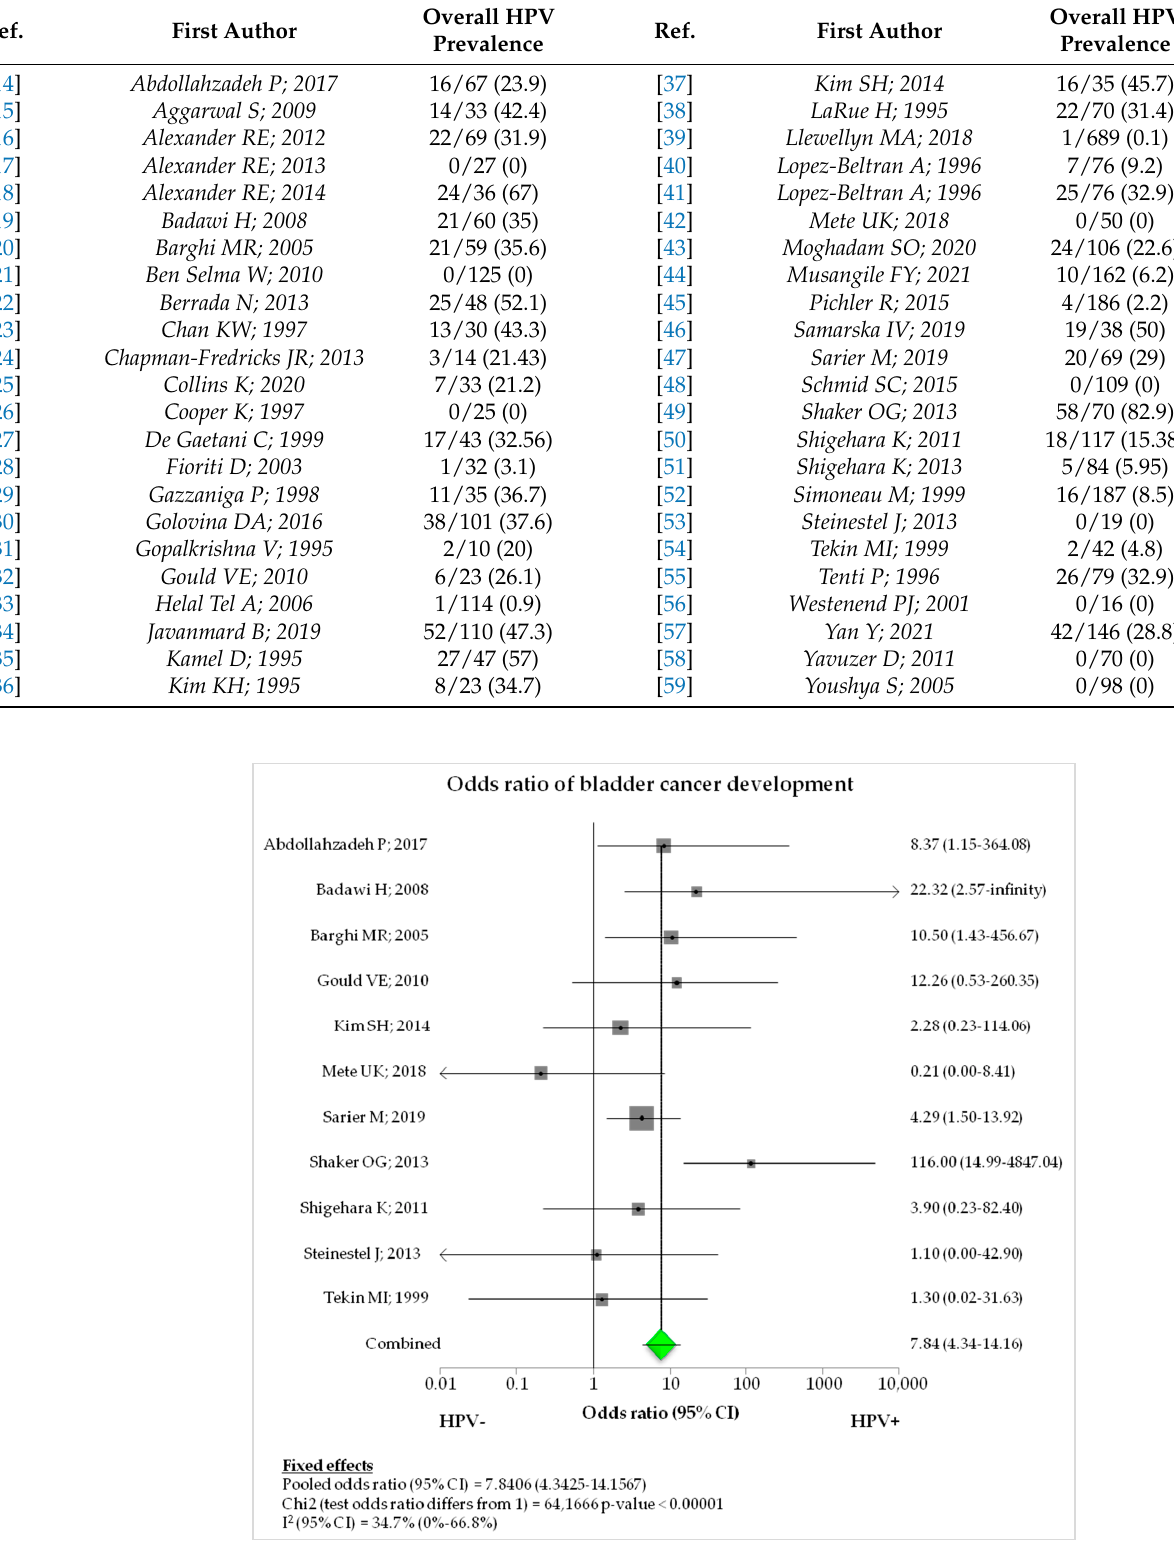
Figure 3. Forest plot of overall odds ratio in case-control studies. Adapted from [14,19,20,32,37,42,47,49,50,53,54].